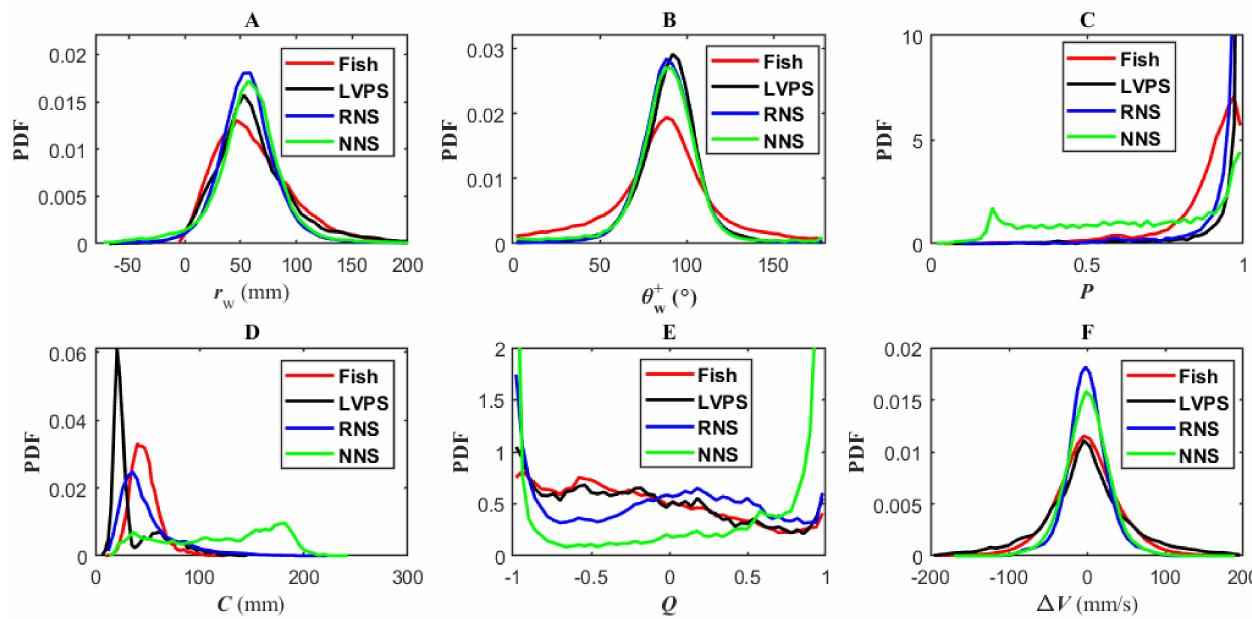
Figure 8. The comparison between the five-fish experiment and the five-agent DNN model simulation. ( A ) PDF of the relative distance from the wall r w of each individual; ( B ) PDF of the absolute value of relative angle to the wall θ + individual; ( C ) PDF of the Polarization P ; ( D ) PDF of the group cohesion C ; ( E ) PDF of collective counter-milling and supper-milling index Q ; ( F ) PDF of relative speed ∆ V of the individual to the